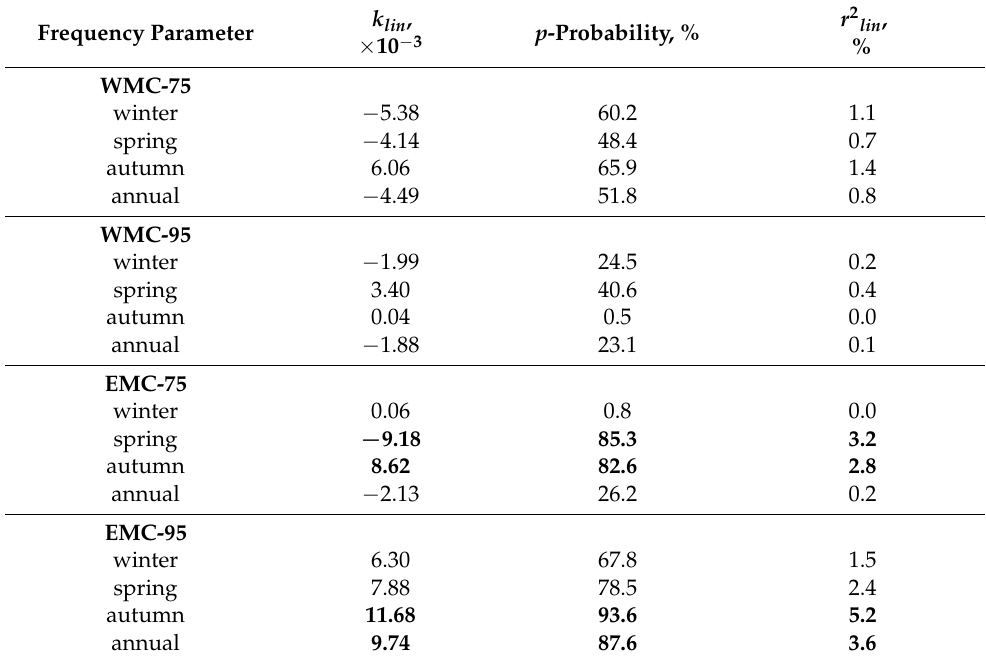
Table 1. Characteristics of linear trends of the frequency of intense/extreme cyclones over the Western and Eastern Mediterranean (WMC-75/WMC-95 and EMC-75/EMC-95, respectively): coeffi- cient of the trend equation ( k lin ), level of significance ( p -probability = 100/( p -value)), coefficient of determination ( r lin 2 ). Significant values are highlighted in bold.